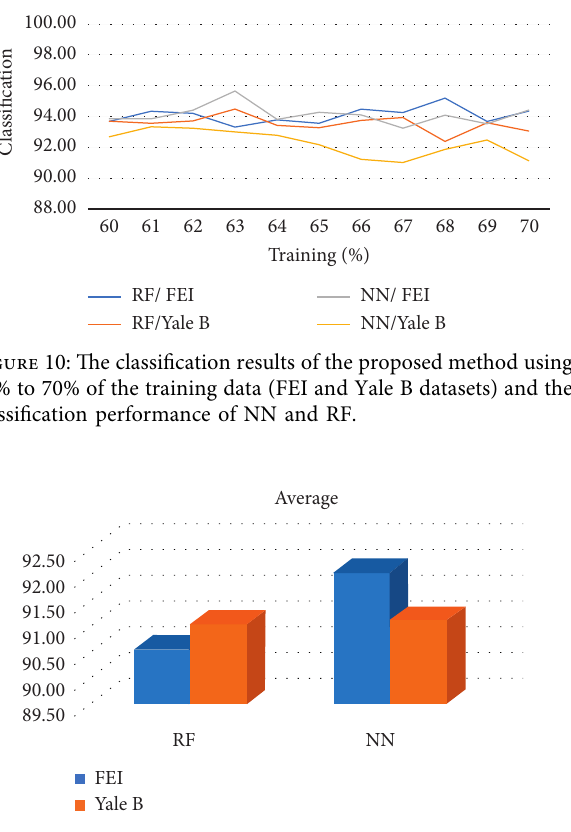
Figure 11: The average accuracy rate series of experiments on BLCM using the FEI and Yale B